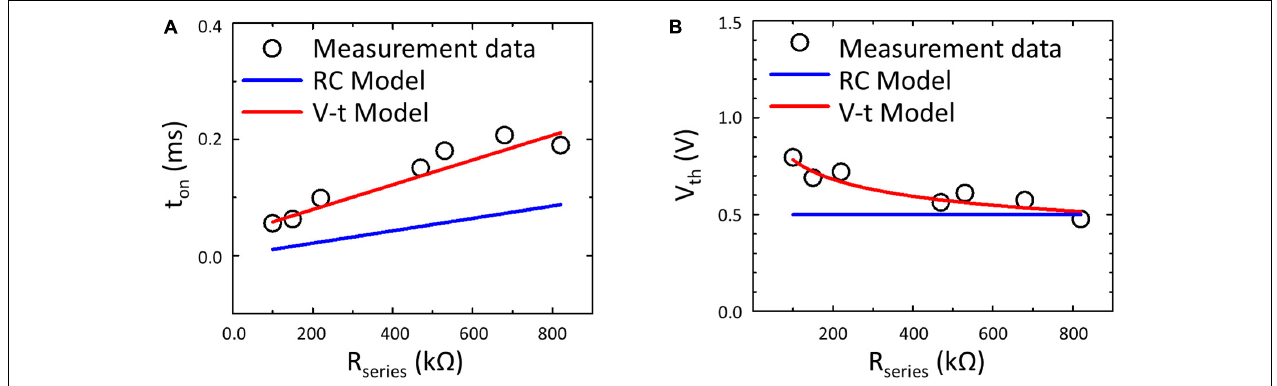
FIGURE 6 | Measurement data and simulated results of (A) t on and (B) V th of the TS neuron with different R series . The results suggest a more accurate prediction based on the V–t Model than the RC Model (Chen et al., 2016; Wang et al., 2020) by considering the history-dependent V th of the TS selector.